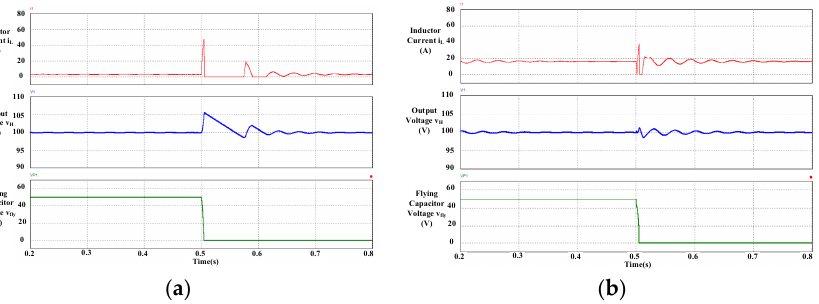
S 3 under different load conditions are shown in Figure 17a,b. The two load conditions are 100 W for a light load and 1000 W for a heavy load. It can be seen that the output voltage of the converter is uninterruptible after the S 3 fault occurs. The spike of the current and Figure 16. The waveforms of S 4 short-circuit fault (V L < 0.5 V H ). ( a ) Light load 100 W; ( b ) heavy load voltage is in the normal range during the mode transition after the fault. 1000 W. Figure 16. The waveforms of S 4 short-circuit fault (V L < 0.5 V H ). ( a ) Light load 100 W; ( b ) heavy load 1000 W.